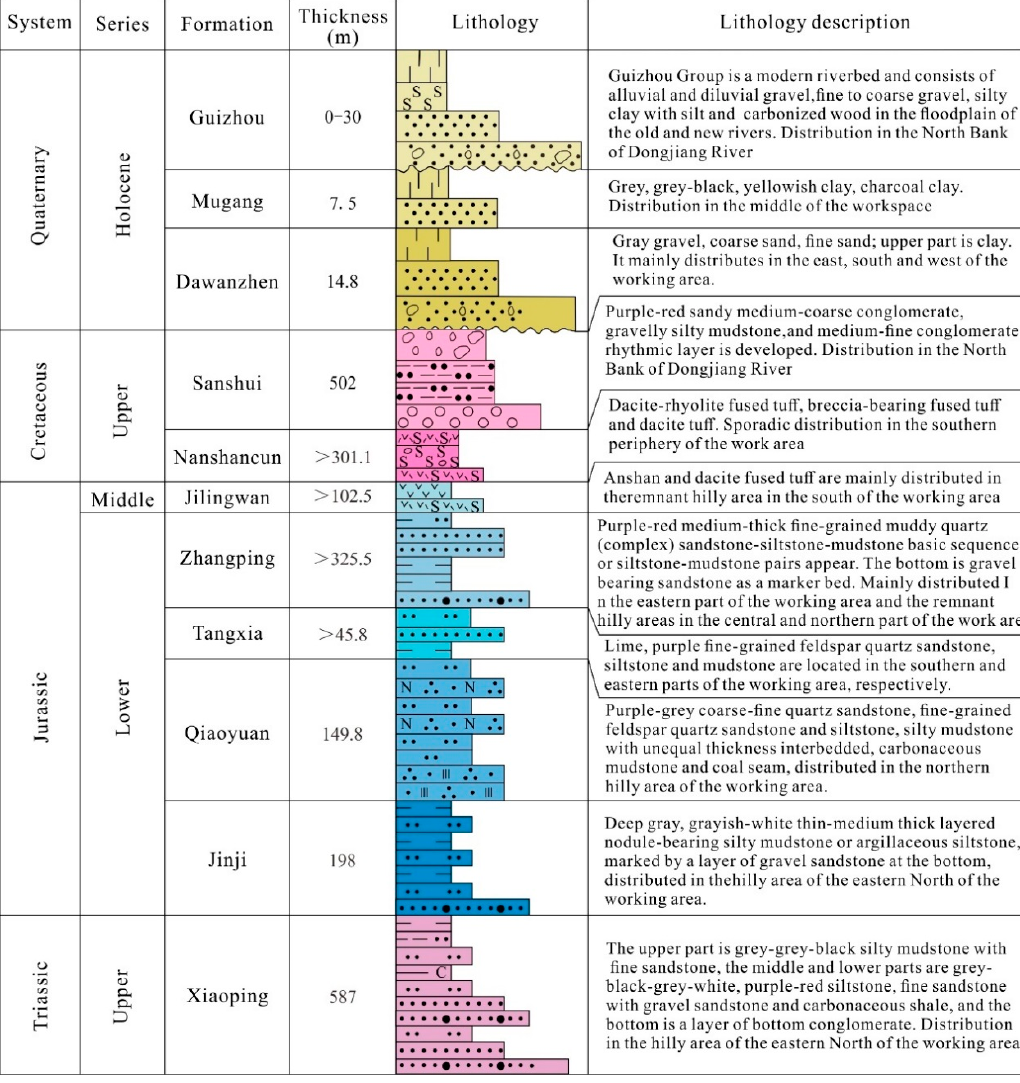
Figure 3. Main strata and lithologic histograms in the study area.